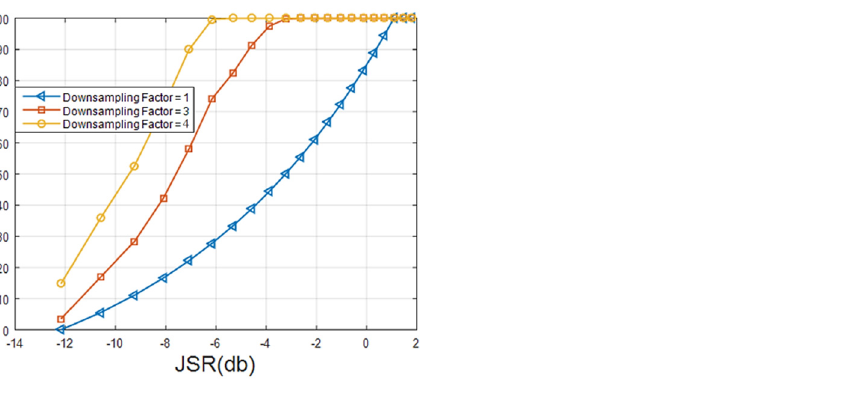
Figure 14. Least Mean Square (LMS) detector [19] performance based on the input JSR ( ε T = 10 − 3 ).